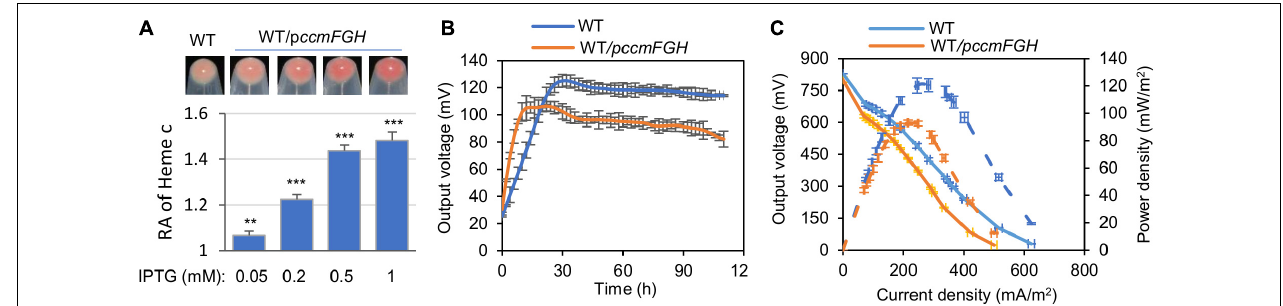
FIGURE 2 | Physical and bioelectrochemical characterization of MR-1 overproducing CcmFGH. (A) Cell pellet color and levels of heme c of indicated strains grown anaerobically on TMAO. Cells in late-exponential phase cultures were pelleted, photographed, and then lysed for quantification of heme c levels. The average heme c level in MR-1 [the wild type (WT)] was set to 1, to which the heme c levels in other strains were normalized, giving the relative abundance (RA). p ccmFGH , controlled expression within plasmid pHGE-Ptac under the control of isopropyl β - D -1-thiogalactoside (IPTG)-inducible promoter P tac . (B) Output voltage of microbial fuel cells (MFCs) incubated with indicated recombinant and the control (WT, carrying empty vector) strains across the 2,000 (cid:127) external resistor. (C) Polarization curves and power density curves determined by measuring the stable output voltage generated across various external resistances. In panels (B,C) , IPTG, 0.5 mM. Three independent operations (biological replicates, throughout the study) were performed, and data are presented by the means ± standard deviation (SD). In panel (A) , asterisks indicate statistically significant difference when compared with the WT values (** p < 0.01; *** p < 0.001). In both (B,C) , the differences in the peak values between two strains were <